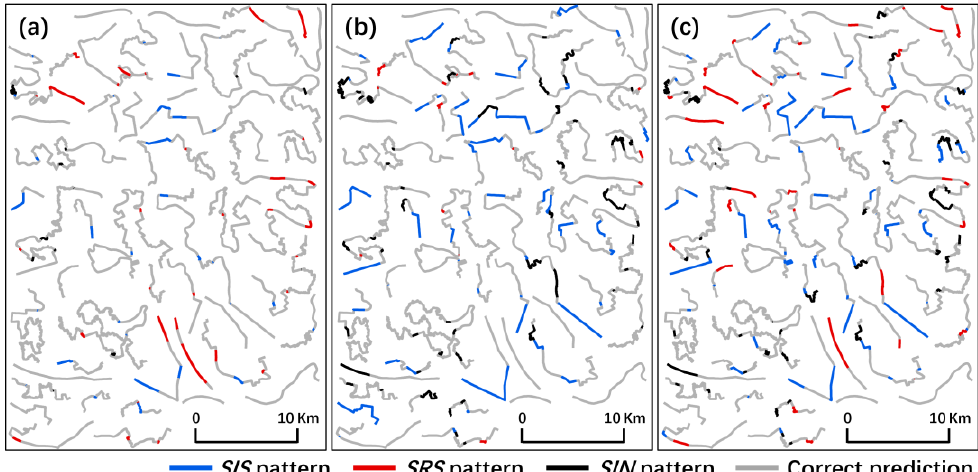
Figure 13. Differences in the manual segmentation results and predicted results of different methods for the test administrative boundaries: ( a ) 1D-U-Net, ( b ) BANN method, and ( c ) NB method. Gray indicates that the segmentation results are consistent; blue, red, and black denote the segments with inconsistent predictions as SIS, SRS, and SIN patterns, respectively.